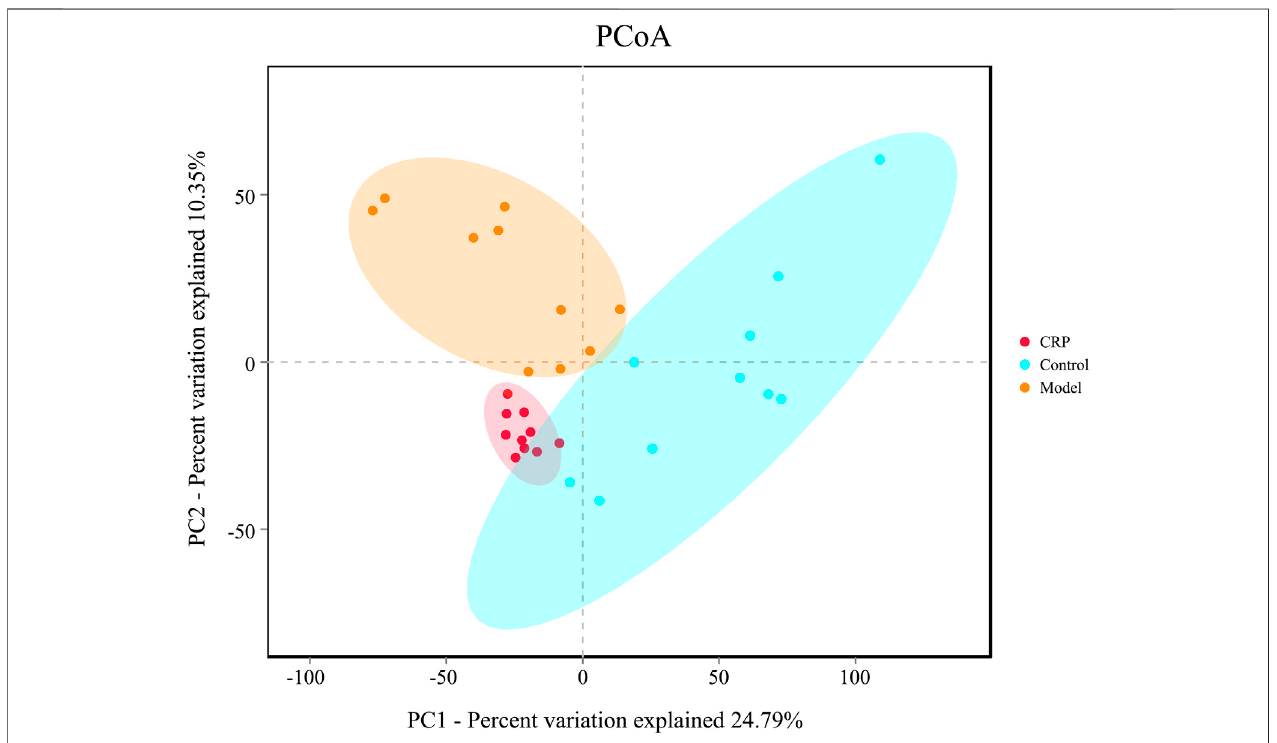
FIGURE 3 | PCoA plot of microbial communities were based on OTU composition, each treatment group is represented by different color. N (cid:2) 10 in each group.